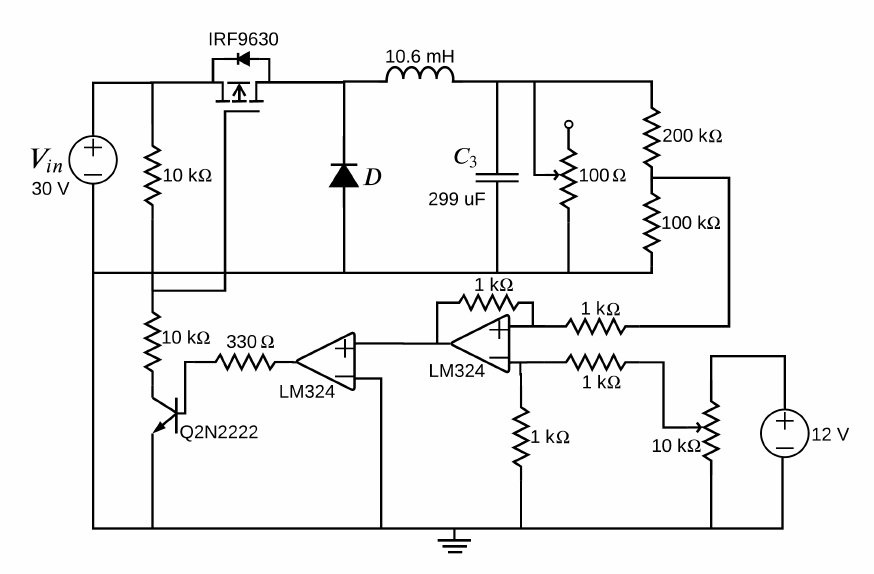
Figure 19. Electronic circuit of the Buck converter with zero hysteresis